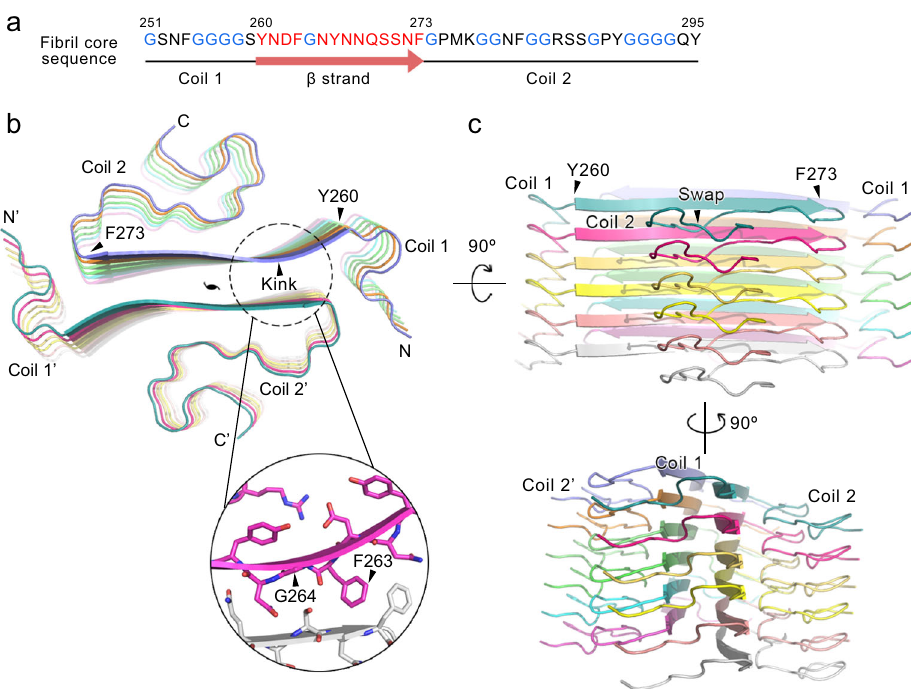
Fig. 2 Overall structure of the hnRNPA1 LC fi bril. a The primary sequence of the hnRNPA1 fi bril core. Residues forming the β -strand are highlighted in red. Glycine residues are in blue. Secondary structures are indicated below. b Top view of the cryoEM structure of hnRNPA1 LC fi bril. Six layers of backbones are shown. The structure is colored by chain. The pseudo-2-fold screw axis is indicated. The sheet kink region is zoomed in with side chains shown. c Side views of the fi bril structure in b